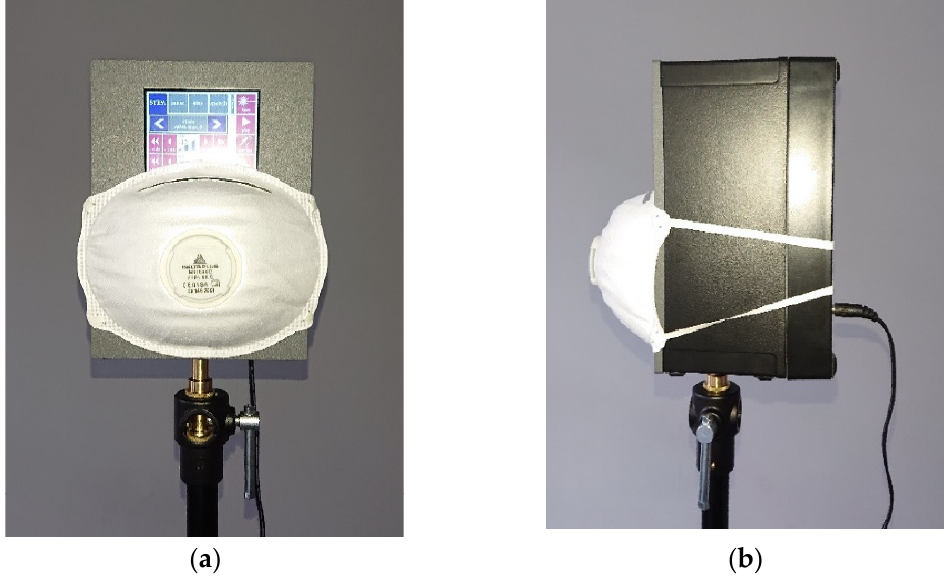
Figure 2. TalkBox with a tested half mask; ( a )—front view, ( b )—side view .